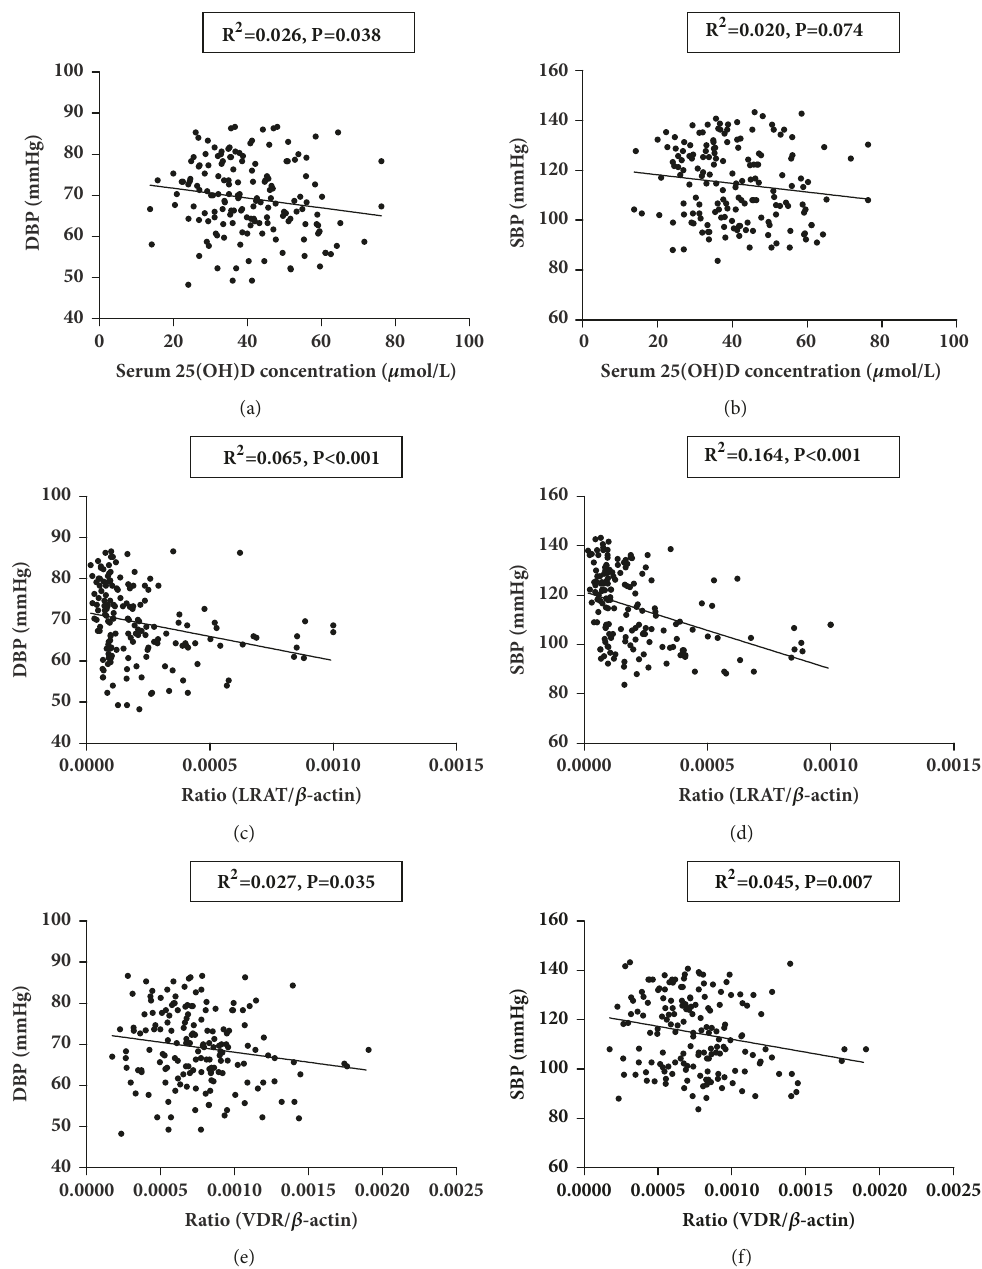
Figure 3: The Correlation Analysis of VA and VD with SBP and DBP (n=164). (a) The correlation between serum 25(OH)D levels (umol/L) and DBP. (b) The correlation between serum 25(OH)D levels (umol/L) and SBP. (c) The correlation between the level of LRAT mRNA expression and DBP. (d) The correlation between the level of LRAT mRNA expression and SBP. (e) The correlation between the level of VDR mRNA expression and DBP. (f) The correlation between the level of VDR mRNA expression and